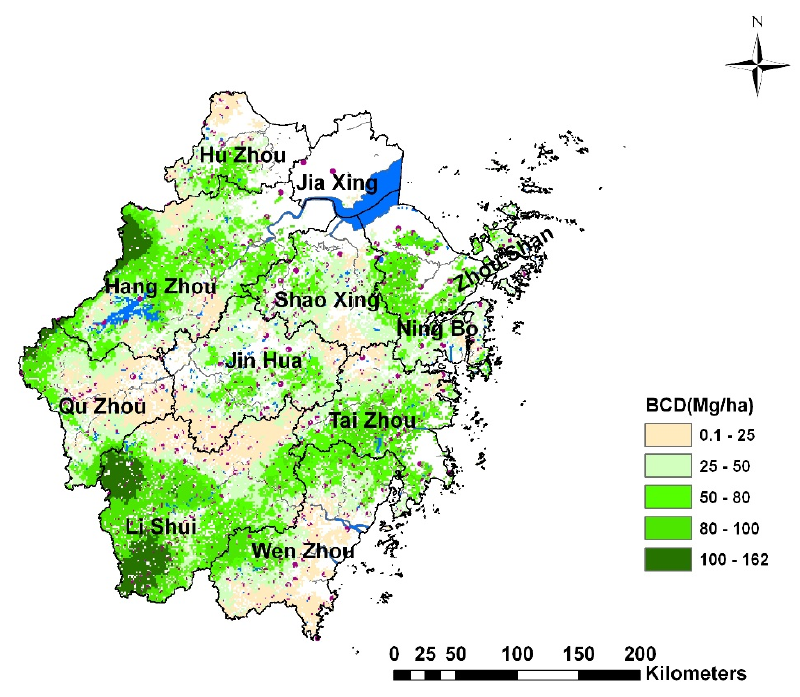
Figure 7. Spatial distribution map of FBC